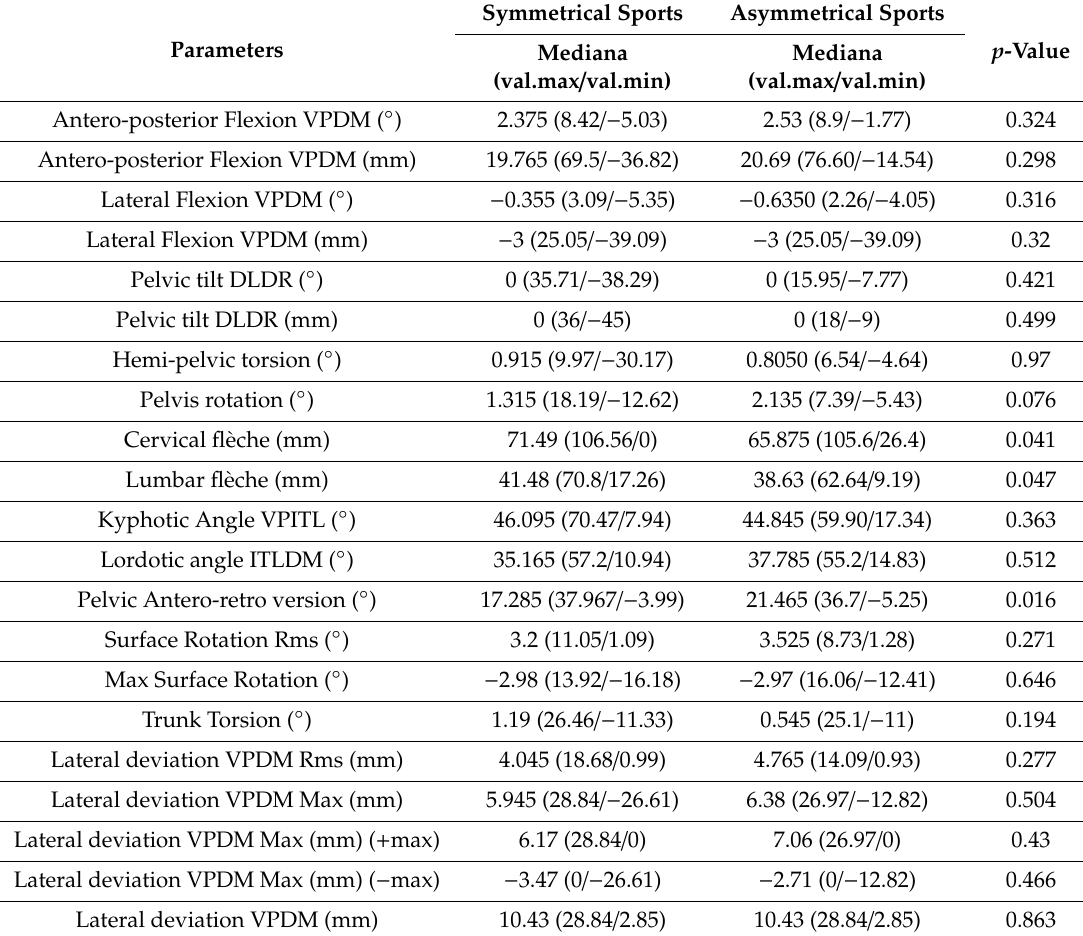
Table 1. Postural comparison between Symmetrical and Asymmetrical sports.